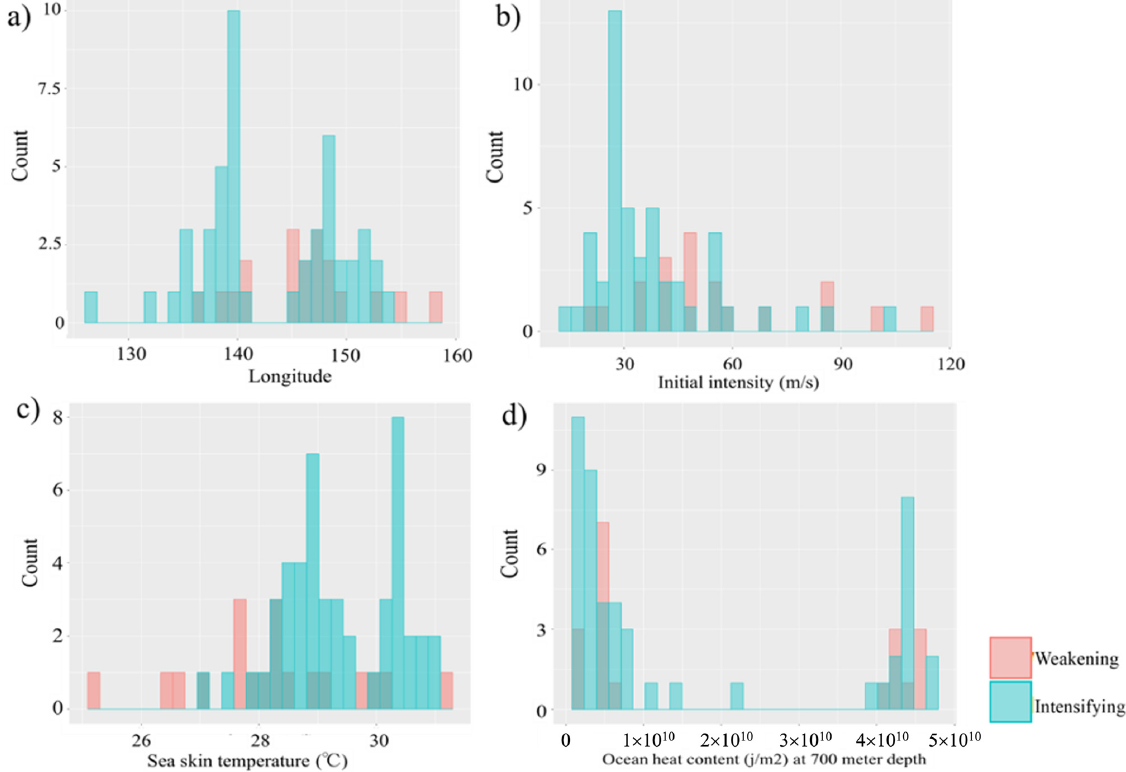
Figure 7. Histograms showing the frequency distribution of ( a ) longitude, ( b ) initial intensity, ( c ) SkT, and ( d ) OHC at 700 m for the intensifying and weakening cases of the Australia mainland landfall TCs. The four most important variables were identified by the